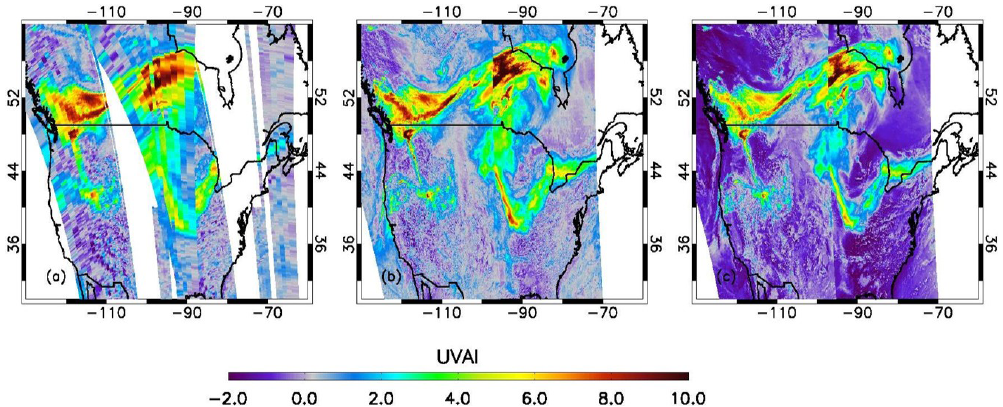
Figure 2. Observed UVAI on 18 August 2018 over North America from (a) OMI observations, (b) TROPOMI observations using the NASA algorithm, and (c) the TROPOMI operational ESA/KNMI product.